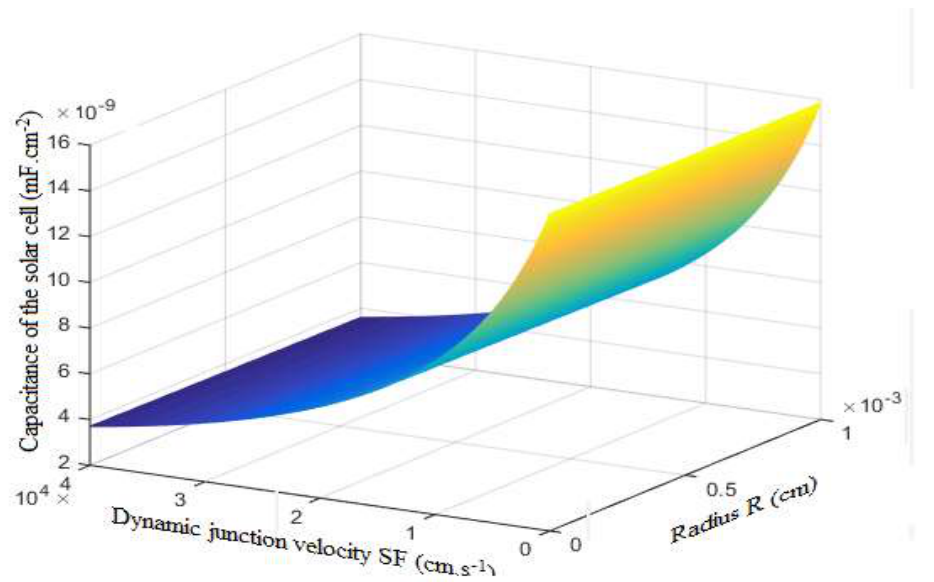
Figure 5. Capacitance of the illuminated